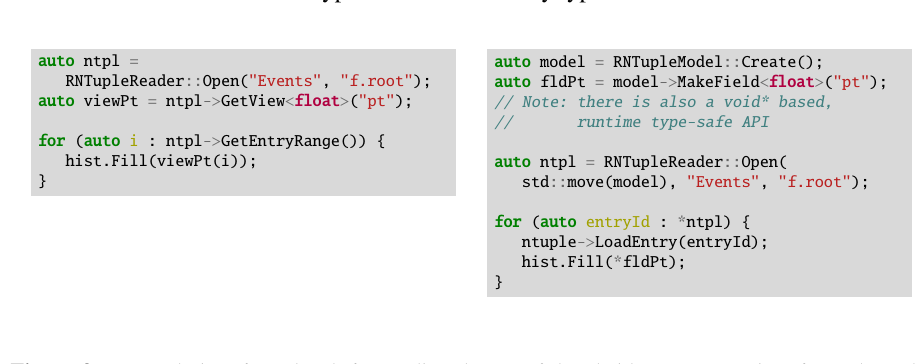
Figure 3. RNTuple interface sketch for reading data. Left-hand side: zero-copy interface where the memory pointed to by views is managed by RNTuple. Right-hand side: interface that copies values into generated or user-provided memory